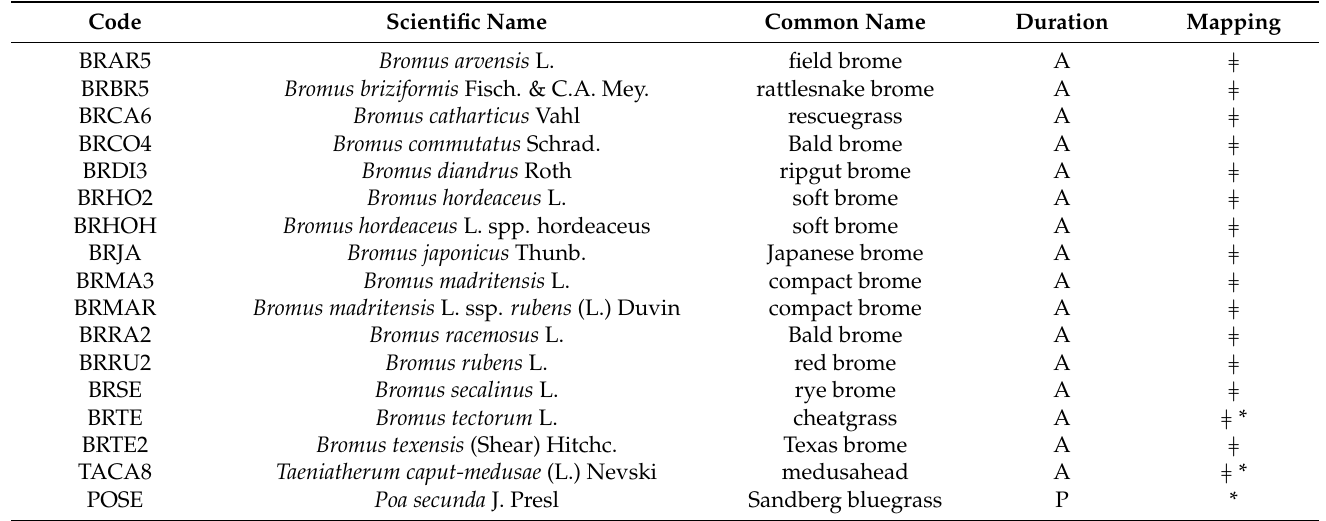
Table 1. List of grass species included in this study. Code as defined by United States Department of Agriculture plants database (https://plants.sc.egov.usda.gov/home, last accessed on 25 January 2022) and adopted by the AIM program